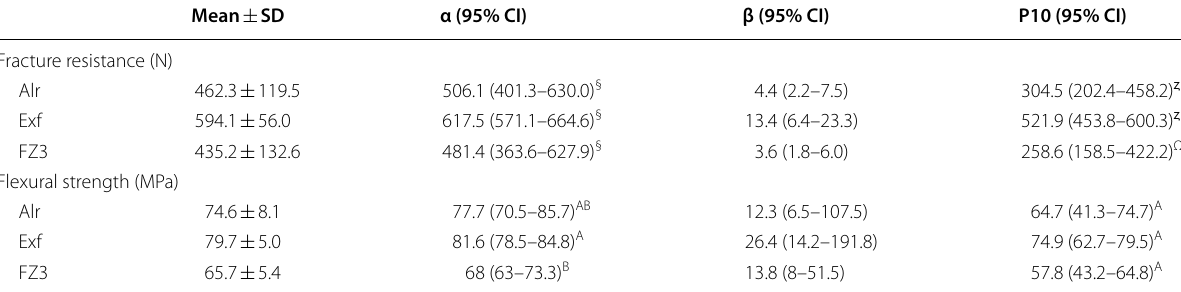
Table 2 Weibull results of fracture strength and flexural strength